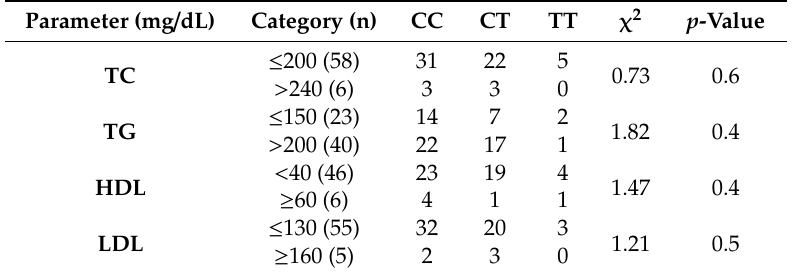
Table 6. Relationship between FokI polymorphism genotypes and lipid profile parameters in T2DM patients ( n = 82).